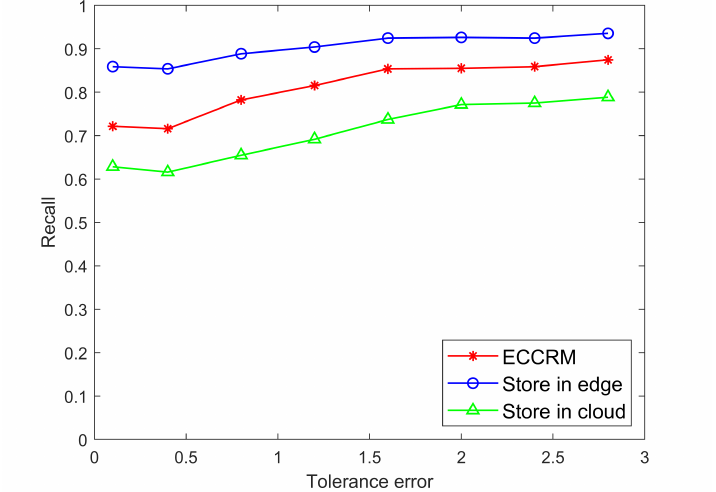
Figure 11. Comparison of recall of different store scheme under different tolerance